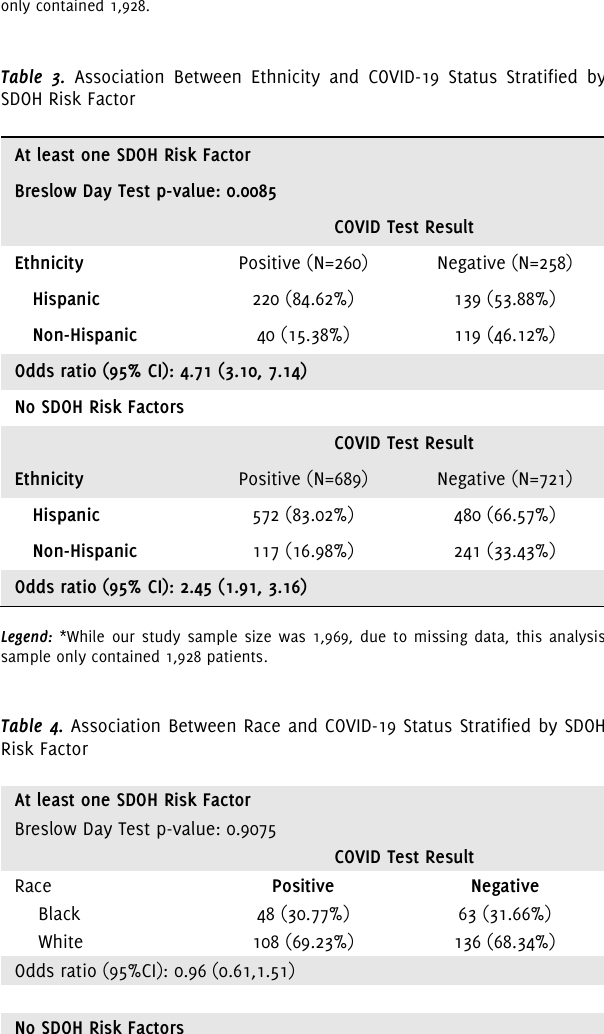
Table 2. Association Between Ethnicity and COVID-19, Before and After Adjusting for Age* Ethnicity